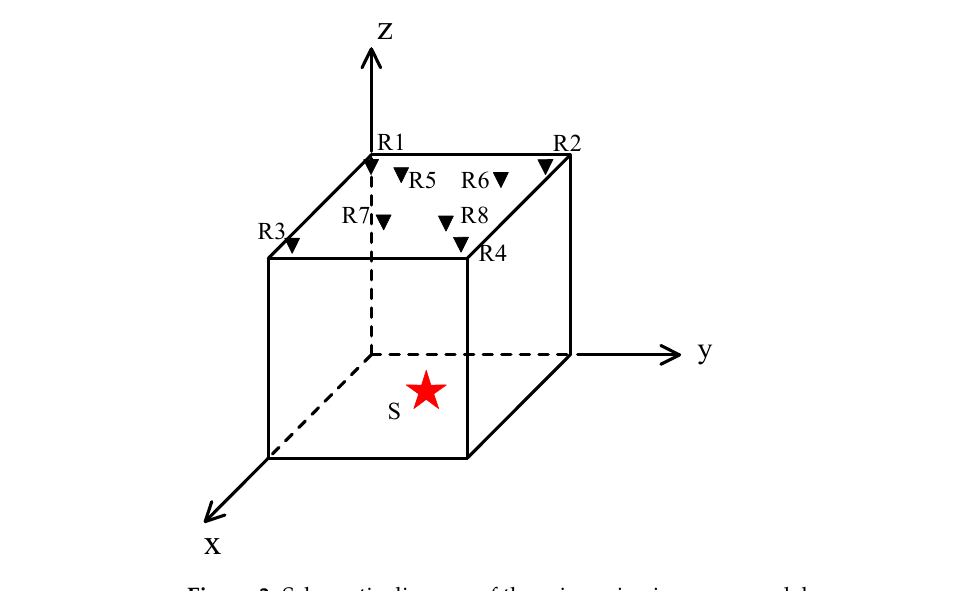
Figure 3. Schematic diagram of the microseismic source model. The distance from the source point to each node, divided by the velocity, was taken as the analytical solution. In other words, the theoretical value of arrival time of the first break, which was expressed as Equation (6). The calculation results of 3D_H_FMM and 3D_FMM were taken as the numerical solution. The difference between the absolute values of the numerical solution and the analytic solution was then taken as the absolute error at each node and expressed as Equation (7). The relative error value of the numerical and analytical solutions was taken as the error degree, and the accuracy was expressed as Equation (8). Therefore, according to the two methods, the MAE and the accuracy of the multiple nodes within the scope of the model were calculated, which were then expressed as Equations (9) and (10), respectively. The specific expressions are as follows: